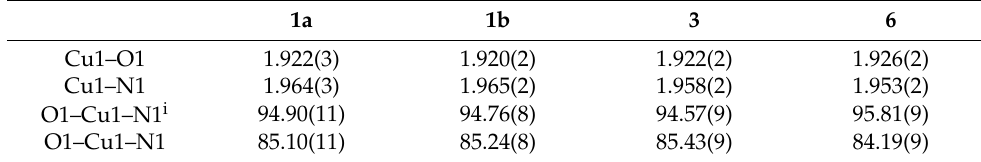
Figure 3. Molecular structure of 1b , 3 and 6 (left to right). Displacement ellipsoids are drawn at the Table 1. Selected bond lengths [Å] and angles [°] for 1a , 1b , 3 and 6 .